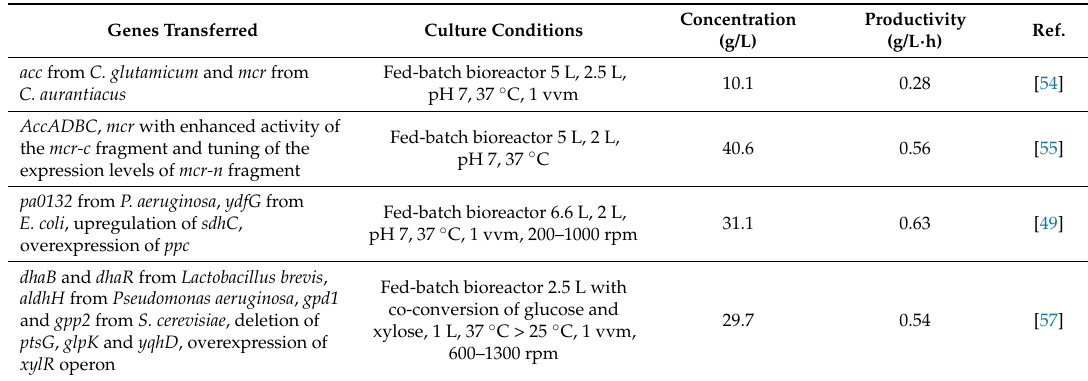
Table 4. Results of 3HP production from glucose using E. coli as host